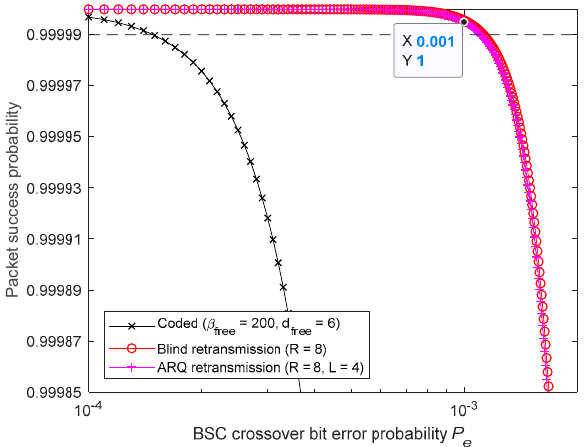
Figure 25. Meeting 99.999% reliability target by using BR and 4-Rep-ACK retransmissions.